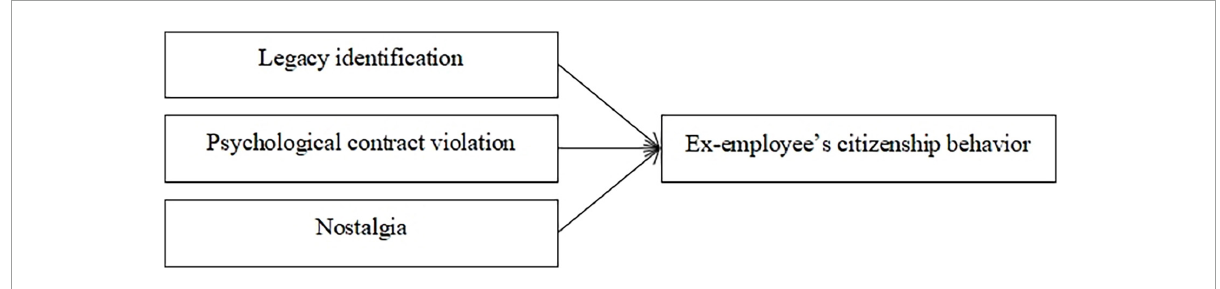
FIGURE2 The nomological network among Ex-ECB, LI, PCV, and